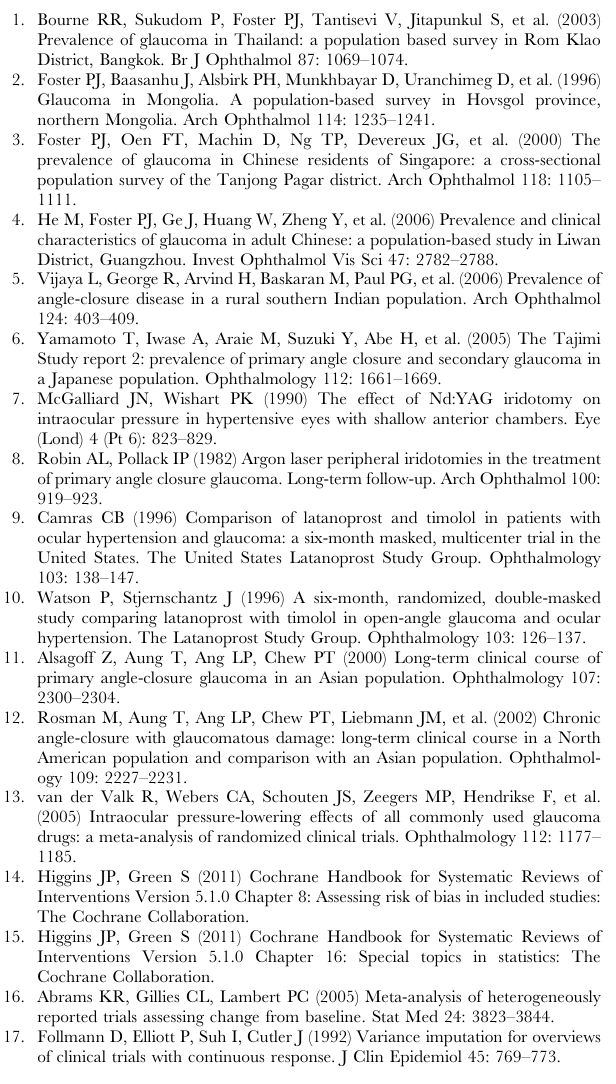
Table S1 Search strategy and results. Table S2 Sensitivity analysis of absolute IOP reduction at peak between latanoprost and timolol. Table S3 Subgroup analysis of IOP reduction between latanoprost and timolol in Chinese Mainland population and Other Asia Pacific